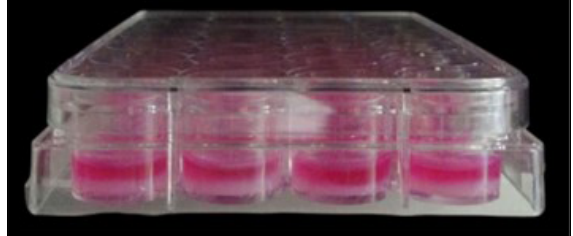
Figure 3 - Conditioned culture medium with hydrogel. The content of two phases in the wells are: culture Dulbecco’s modified eagle medium (pink on the surface), and solid hydrogel (white on the bottom) (n = 5).